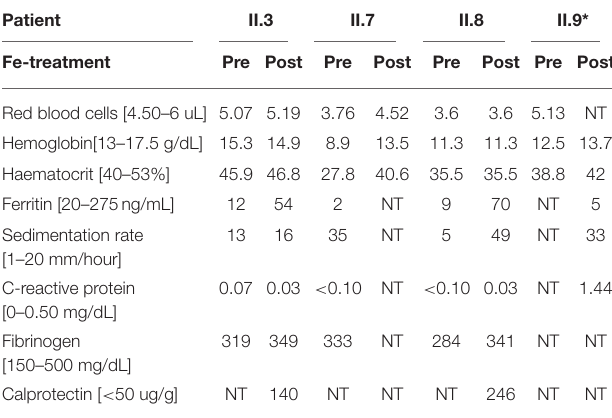
TABLE 1 | Pre and post Fe-treatment serology evaluation of the other members of the family affected with gastric neuroendocrine tumors. Patient